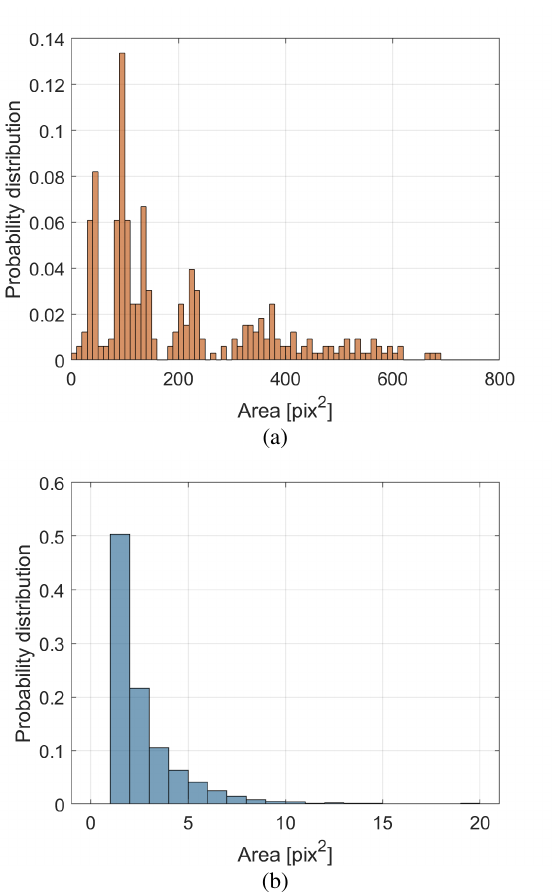
Figure 10. (a) plastic object and (b) false positive (after applying the B+A cascade) areas in the 30 m height dataset.